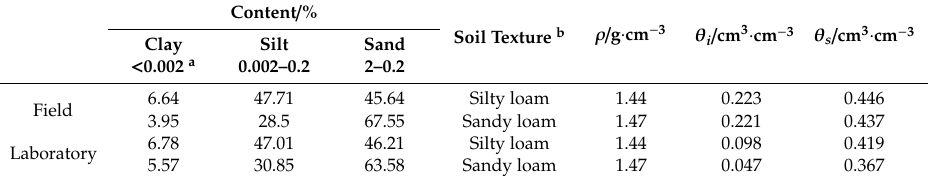
Table 1. Physical properties of soil layers used in this